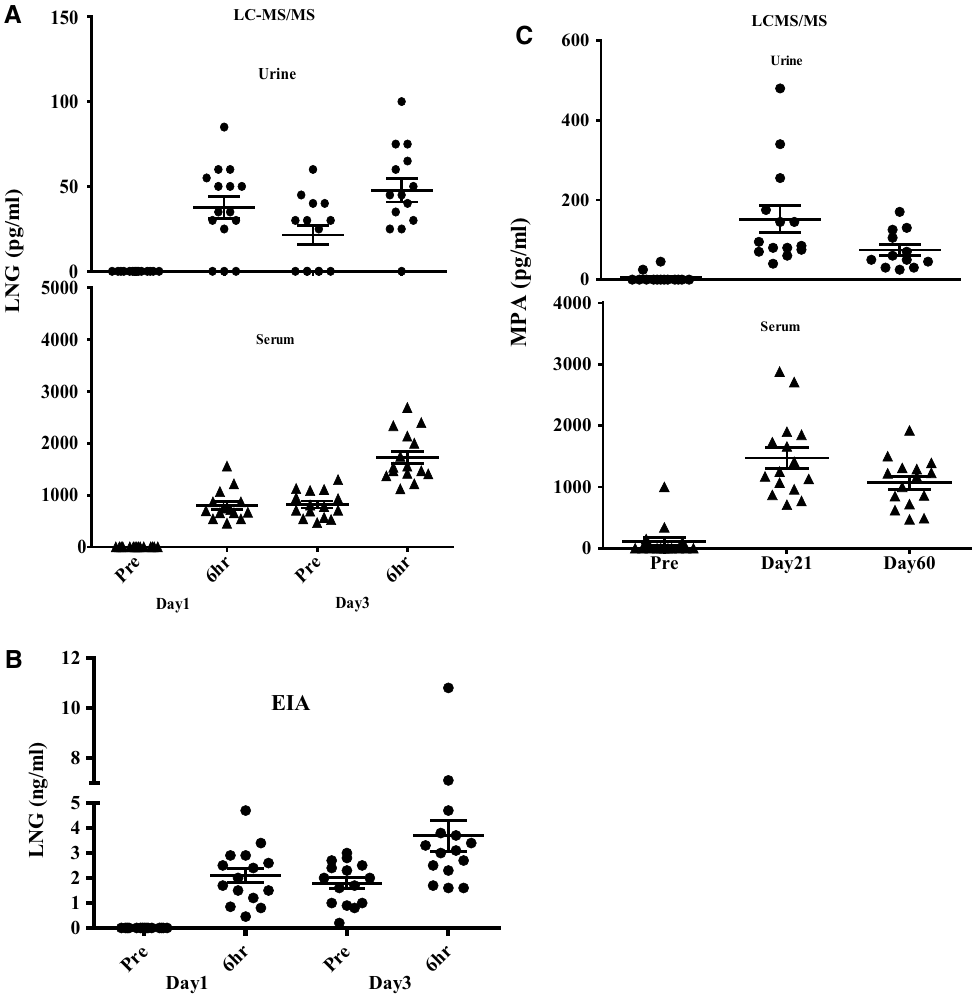
Figure 2. ( A ) Levonorgestrel (LNG) concentrations measured by LCMS/MS method in serum and urine samples were collected on days-1 and 3 of the COC treatment. No individuals showed detectable LNG in serum or urine at baseline (Pre) but all showed an increase at 6 h post ingestion on both days (day-1 and 3). Only eight of 15 participants had detectable levels at all three time points post baseline. Six participants had LNG levels below the level of quantification at the trough timepoint (24 h post dose 2), three of whom also had undetectable levels 6 h after their first dose. ( B ) Levonorgestrel (LNG) concentrations measured by Enzyme Immuno assay (EIA) method in urine samples collected on day-1 and 3 of the COC treatment. No individuals showed detectable LNG in serum or urine at baseline (Pre) and showed detectable levels at all time points post ingestion on both days (day-1 and 3). ( C ) Medroxyprogesterone (MPA) concentrations measured by LC–MS/ MS method in serum and urine samples collected on day 0 (Baseline) and 21 and 60 days after depo injection. Four individuals had detectable MPA in serum prior to receiving their injection, two of whom also had detectable MPA in urine. The two women with undetectable urine MPA but detectable serum MPA had levels below that required for contraceptive efficacy (< 0.2 ng/mL). One individual with undetectable serum MPA, had detectable urine MPA, with the level in the urine slightly above the serum threshold level (< 0.2 ng/mL). We detected MPA in serum and urine of all participants at 21- and 60-days post injection.